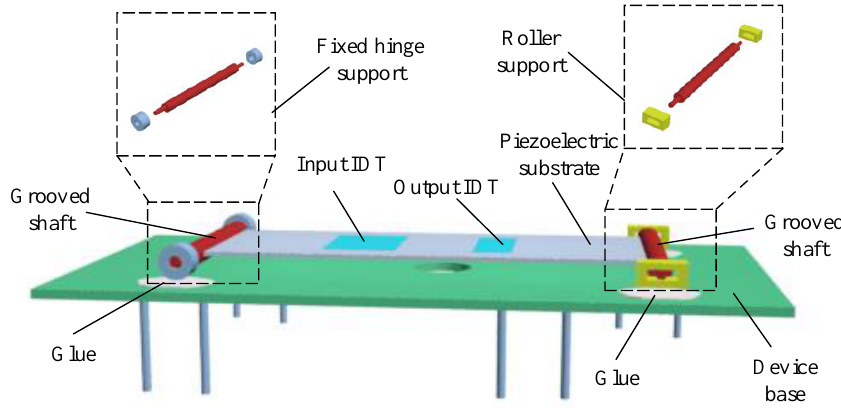
Figure 8. Model diagram of simply supported beam SAW sensor.